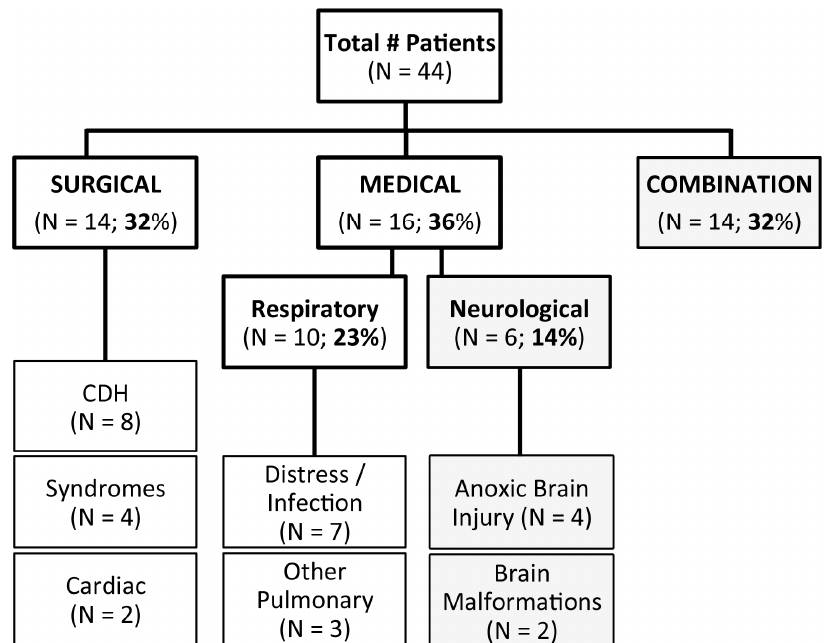
Figure 2. Identified disease profiles of patients undergoing prolonged sedation. Chart represents numerical summary of infants that met criteria for retrospective study over a search period of 1 year. Only full-term infants (without known chromosomal abnormalities) that received sedation for longer than 3 days in the first year of life were included. Figure summarizes disease profiles of all patients included in the study ( n = 44). Approximately, one-third required surgical repair ( n = 14; 32%), another third underwent medical treatment (either due to respiratory ( n = 10; 23%) or neurological disease ( n = 6; 14%)), and the remaining third had a combination of either surgical or medical disease that also included neurological involvement ( n = 14; 32%). Infants undergoing major surgery ( n = 14) were diagnosed with various diseases such as congenital diaphragmatic hernia (CDH), cardiac anomalies, or syndromes (diseases with more than one identifying feature or symptom). Infants with respiratory diseases ( n = 10) were diagnosed with respiratory distress / infection or other (e.g., pulmonary hypertension or hemorrhage).